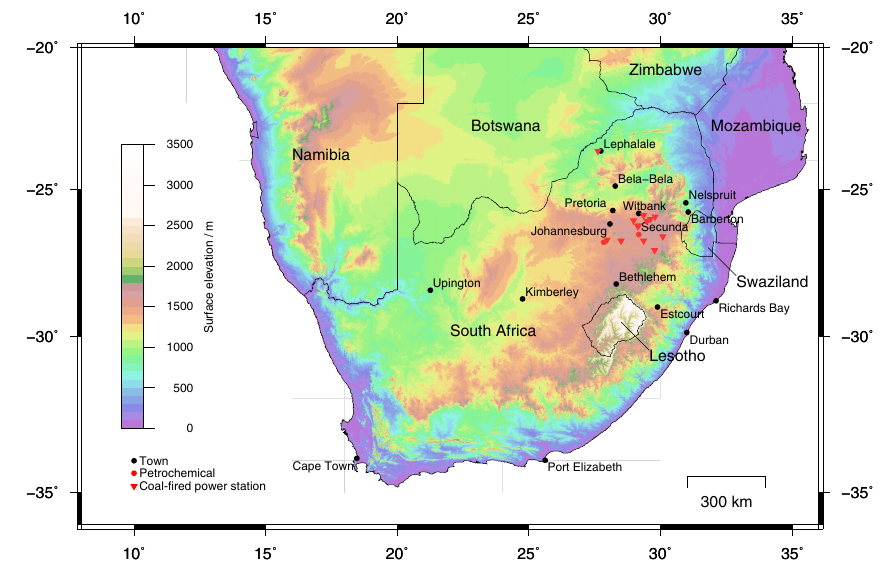
Figure 1. A map of southern Africa, showing the high-altitude plateau of the Highveld to the east of Johannesburg, and the cluster of coal- fired power stations and heavy industries on the eastern Highveld. The coal-fired power station at Lephalale is indicated. Power stations not shown here include smaller coal-fired and gas turbine power stations operated by